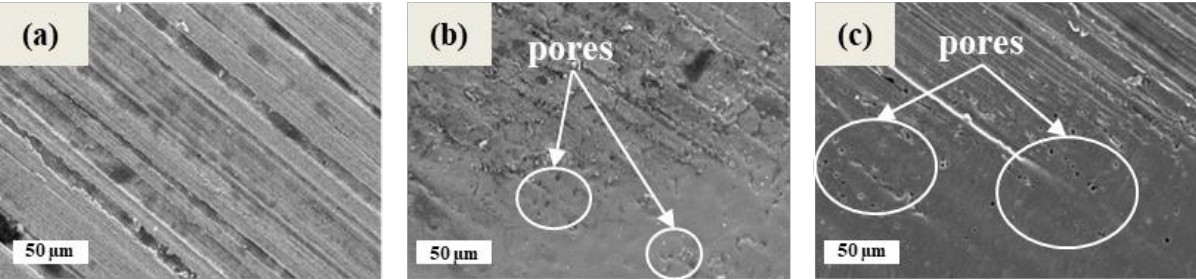
Figure 4. Scanning electron microscopy ( SEM) micrographs of Nimonic 263 sample surface before laser treatment ( a ), and the border of the modified surface area and untreated surface area after nanosecond ( b ) and picosecond ( c ) laser treatment.